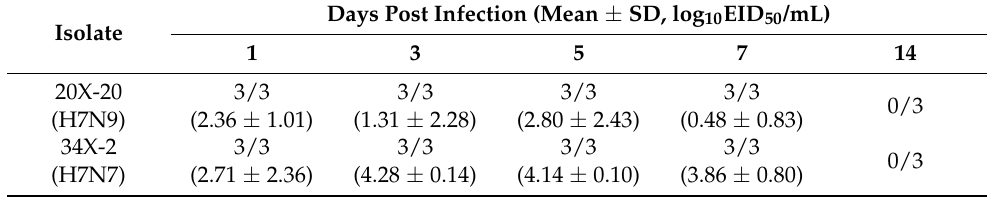
Table 3. Replication of H7 isolates in the lungs of 6-week-old BALB/c mouse. Values shown are the number of infected mice per number of inoculated mice. Values in parentheses are viral titers (log 10 EID 50 /mL). The viral titers are expressed as the mean ± standard deviation (SD) of the samples. The viral titers from the lungs of mice were calculated using the Reed and Muench method.